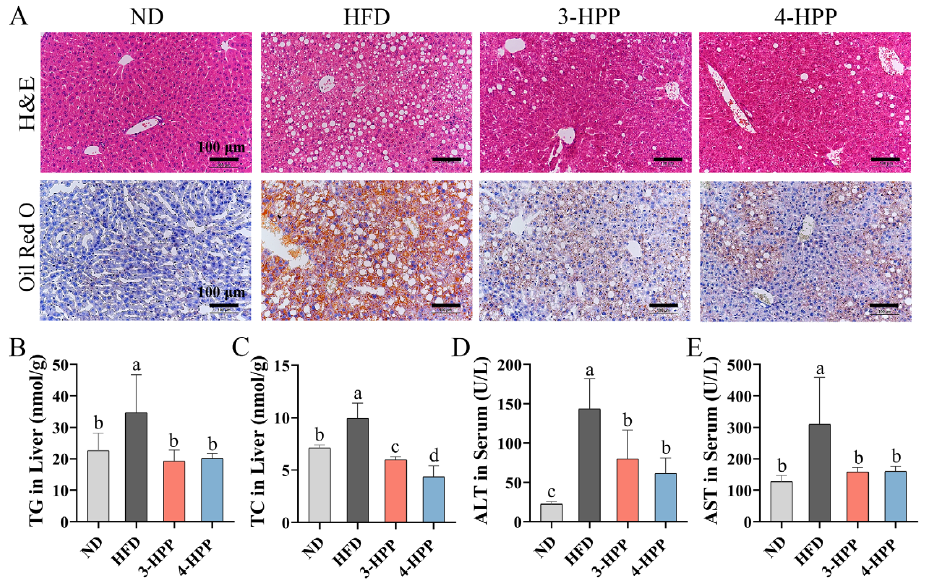
Figure 2. The impacts of 3-HPP and 4-HPP on hepatic steatosis and liver injury. ( A ) Graphs of H&E staining and ORO staining. ( B ) Hepatic TG levels. ( C ) Hepatic TC levels. ( D ) Serum contents of ALT. ( E ) Serum contents of AST. Data are shown as the mean ± SD. n = 6 if not specified. According to Duncan’s test, mean values with different letters mean significant differences at p < 0.05.